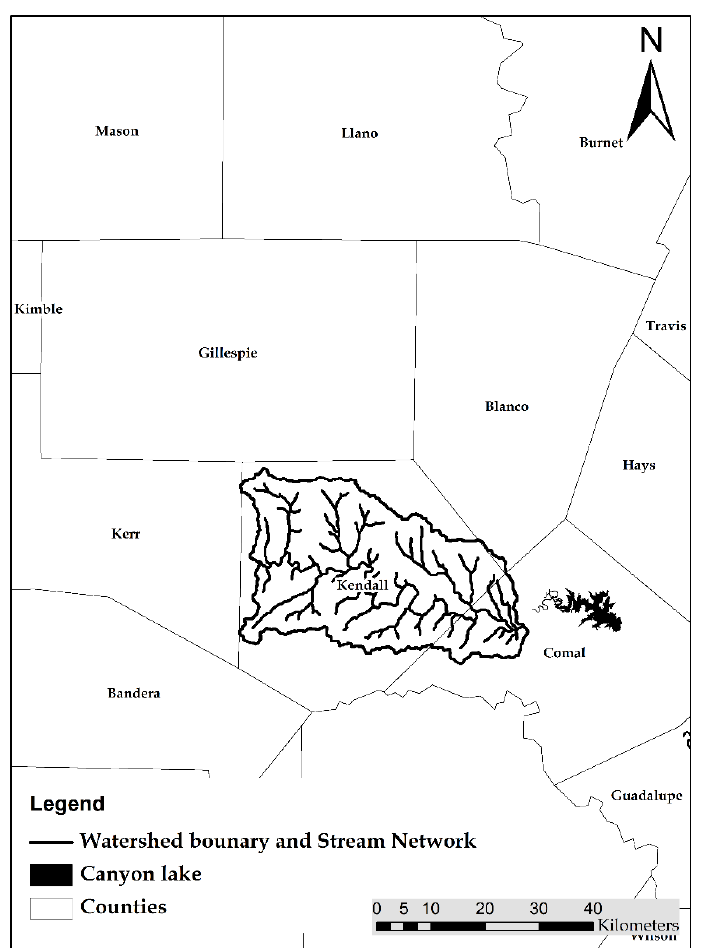
Figure 1. Location of the study area in